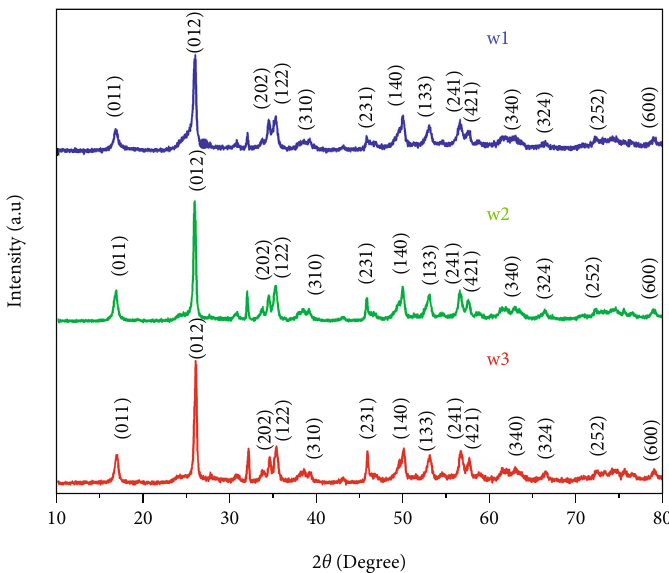
Figure 3: Crystal phase structure of WO